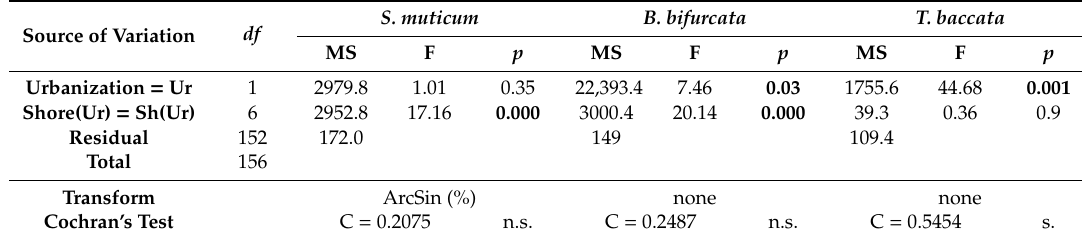
Table 4. Results of ANOVAs testing for di ff erences on main canopy species from urban and non-urban shores. Significant e ff ects are indicated in bold. ns: not significant; s: significant.